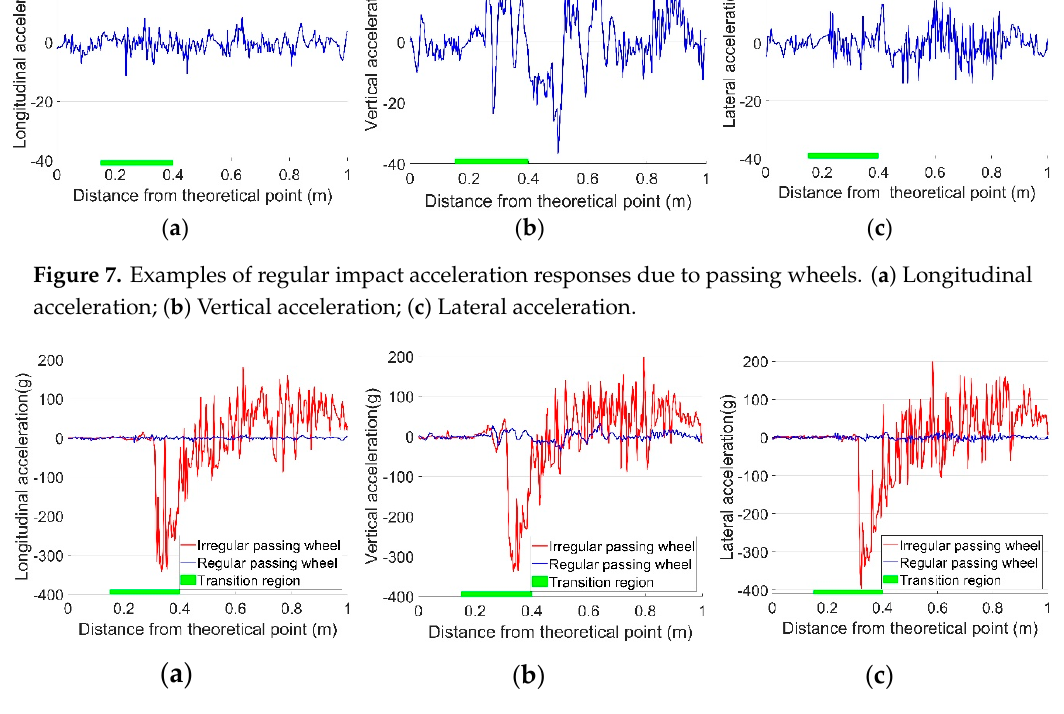
Figure 8. Examples of regular (same as Figure 7) and irregular impact acceleration responses due to passing wheels. ( a ) Longitudinal acceleration; ( b ) Vertical acceleration; ( c ) Lateral acceleration.